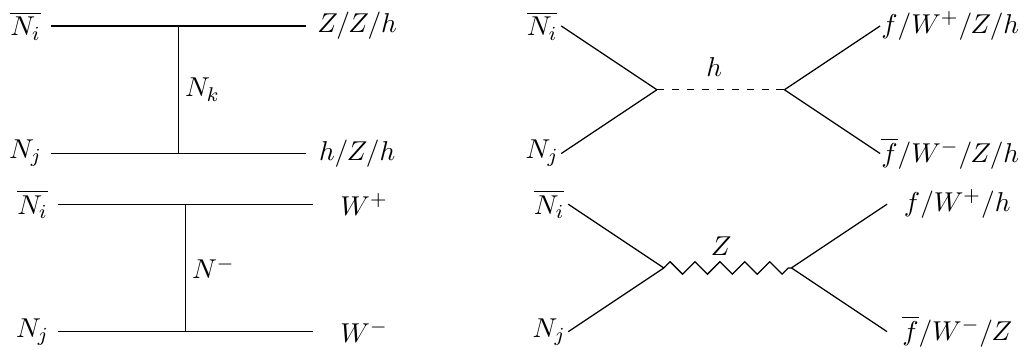
Figure 23 . Annihilation ( i = j ) and Co-annihilation ( i